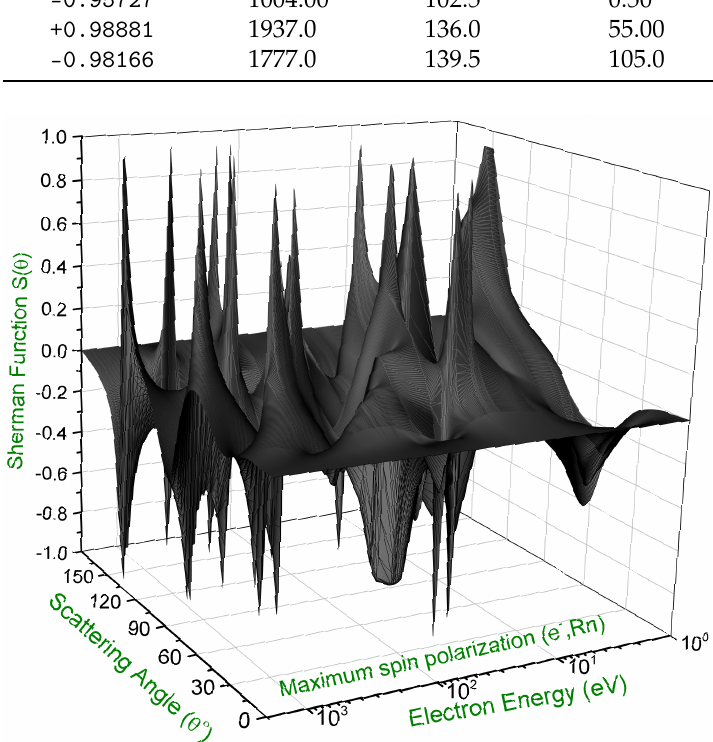
Figure 17. A 3D-plot of the present Sherman function for electrons elastically scattered from neutral radon